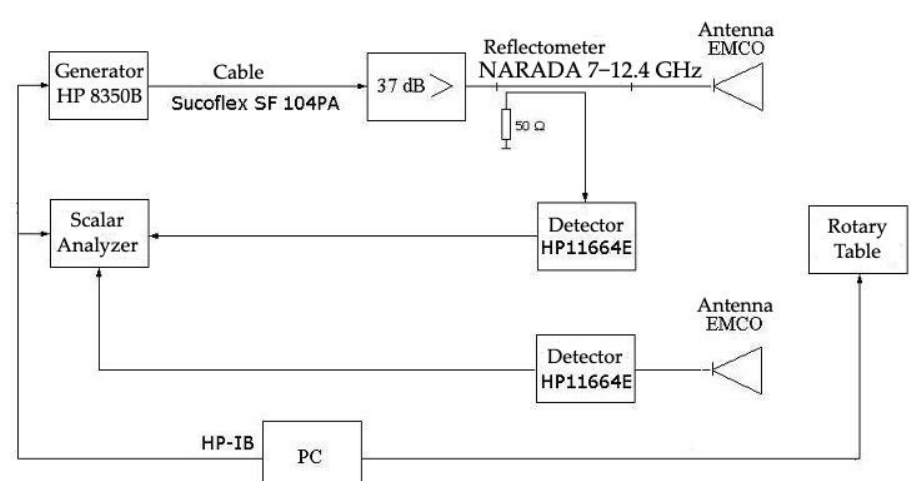
Figure 4. Functional diagram of the measuring station using the Radar Cross Section RCS method.